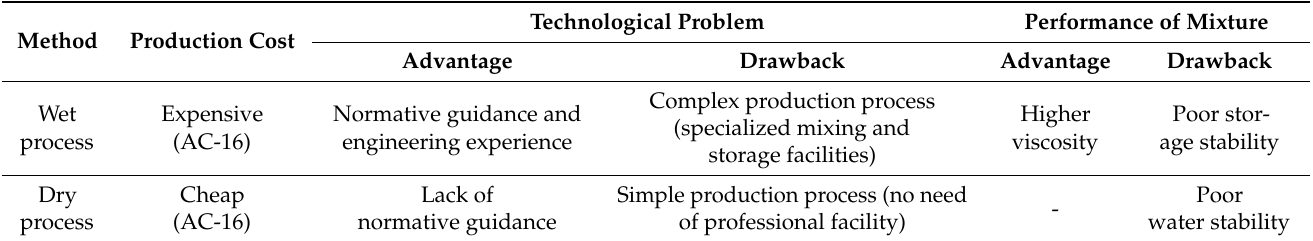
Table 3. The advantages and drawbacks of different